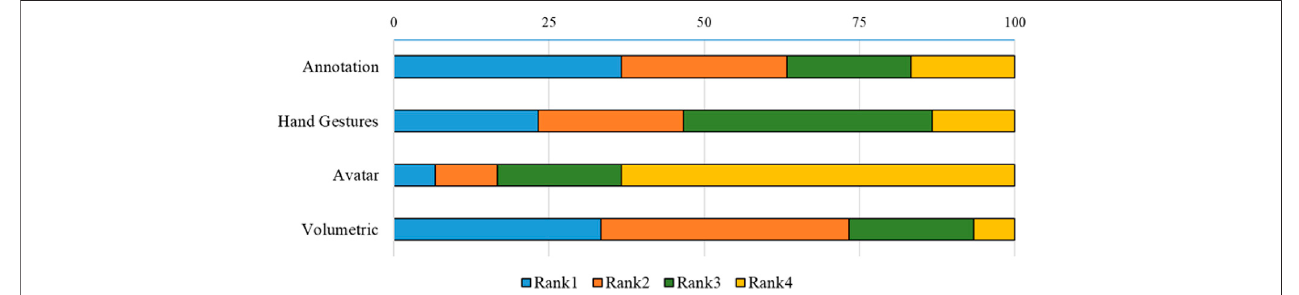
FIGURE 9 | Results of SUS questionnaire (100-points range with 80.3 or higher isconsidered good, 68 and above classi fi ed as average and below 51 considered poor usability).